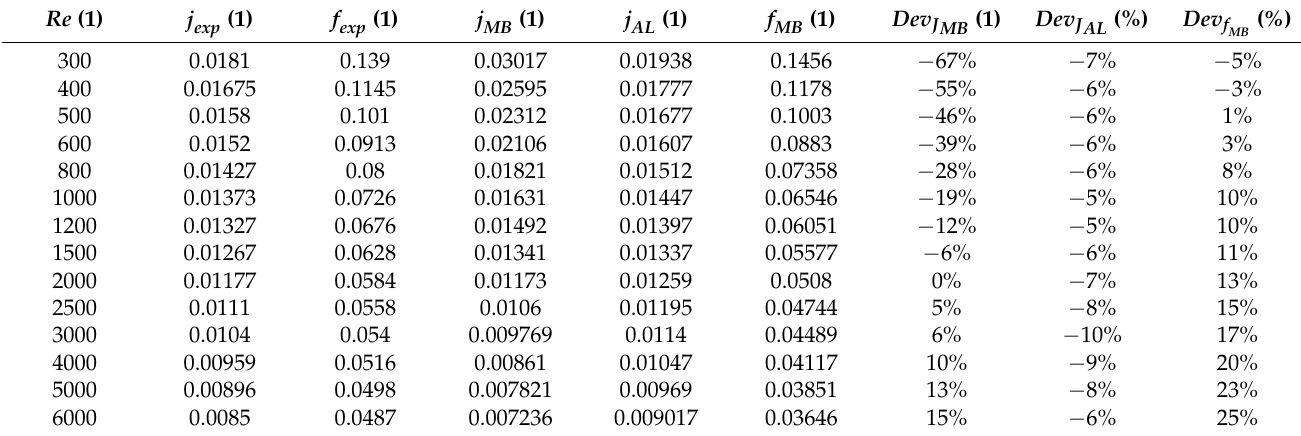
Table 4. Average deviation for Colburn and friction factor for strip fin surface